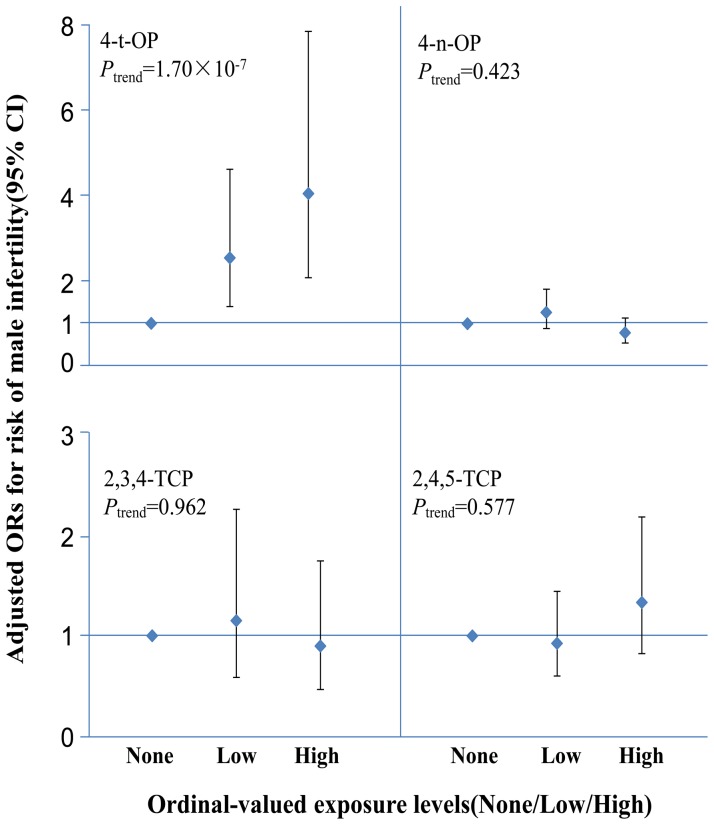
Adjusted ORs for risk of male infertility (95%CI).Logistic regression was used with categories of ordinal-valued exposure variables of 4-t-OP, 4-n-OP, 2,3,4-TCP and 2,4,5-TCP, adjusted for age, BMI and creatinine (n = 985).